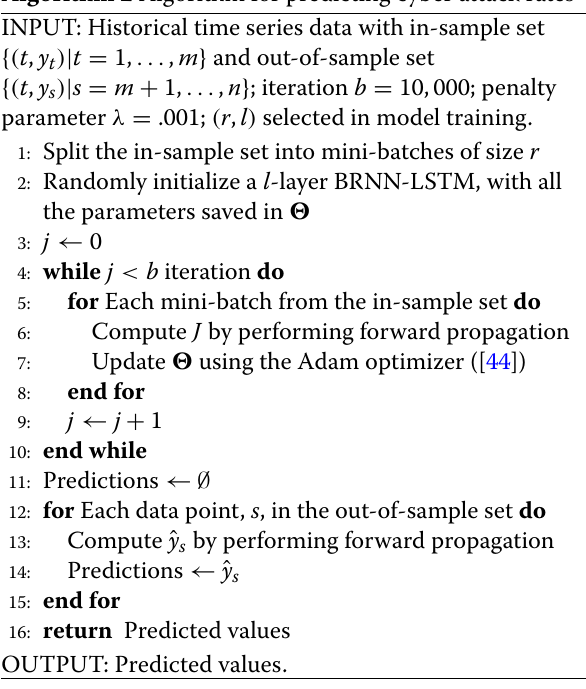
Algorithm 2 Algorithm for predicting cyber attack